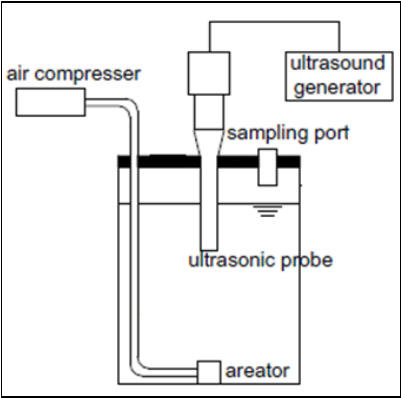
Figure 1. Schematic diagram of the